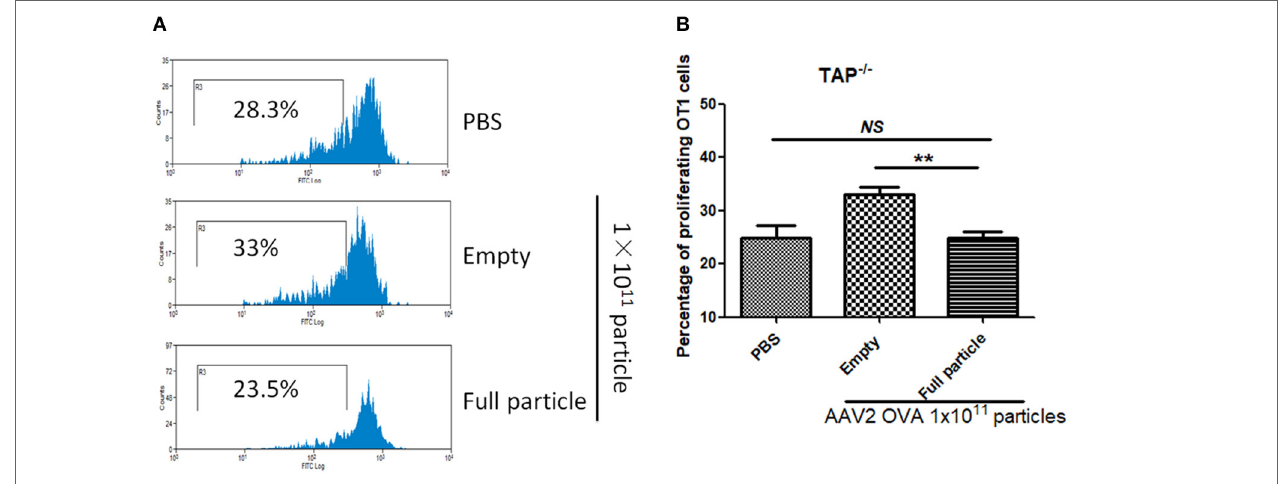
FigUre 8 | Blockage of proteasome pathway inhibits capsid antigen presentation from empty capsid. 1 × 10 11 particles of AAV2OVA vectors (empty or full) were intravenously injected into TAP − / − mice via retro-orbital vein. At day 3, OT-1 cells were administered into the mice. Ten days later, spleen cells from mice were harvested for capsid antigen presentation analysis. (a) Representative flow cytometric histograms in TAP − / − mice treated with adeno-associated virus particles. (B) Average T cell proliferation and SD for five mice. ** p < 0.01 when compared to mice treated with AAV2OVA full particles in TAP − / −